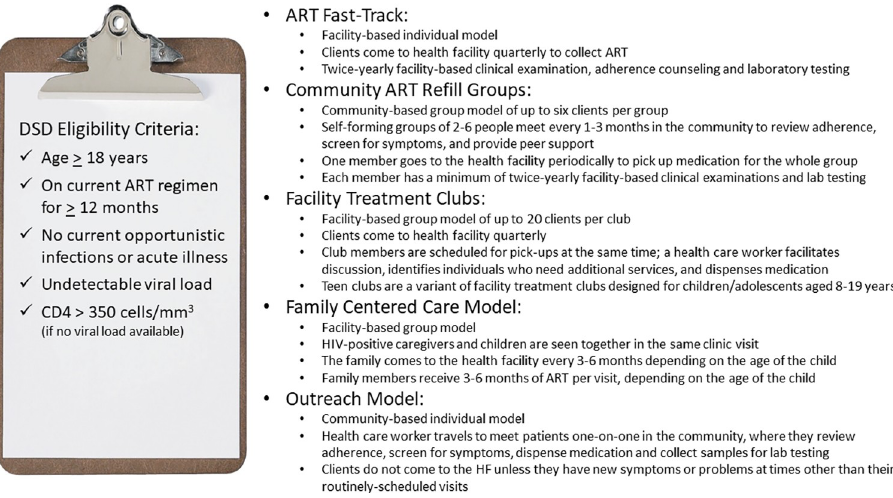
Fig 1. Differentiated ART models and features, and eligibility criteria,